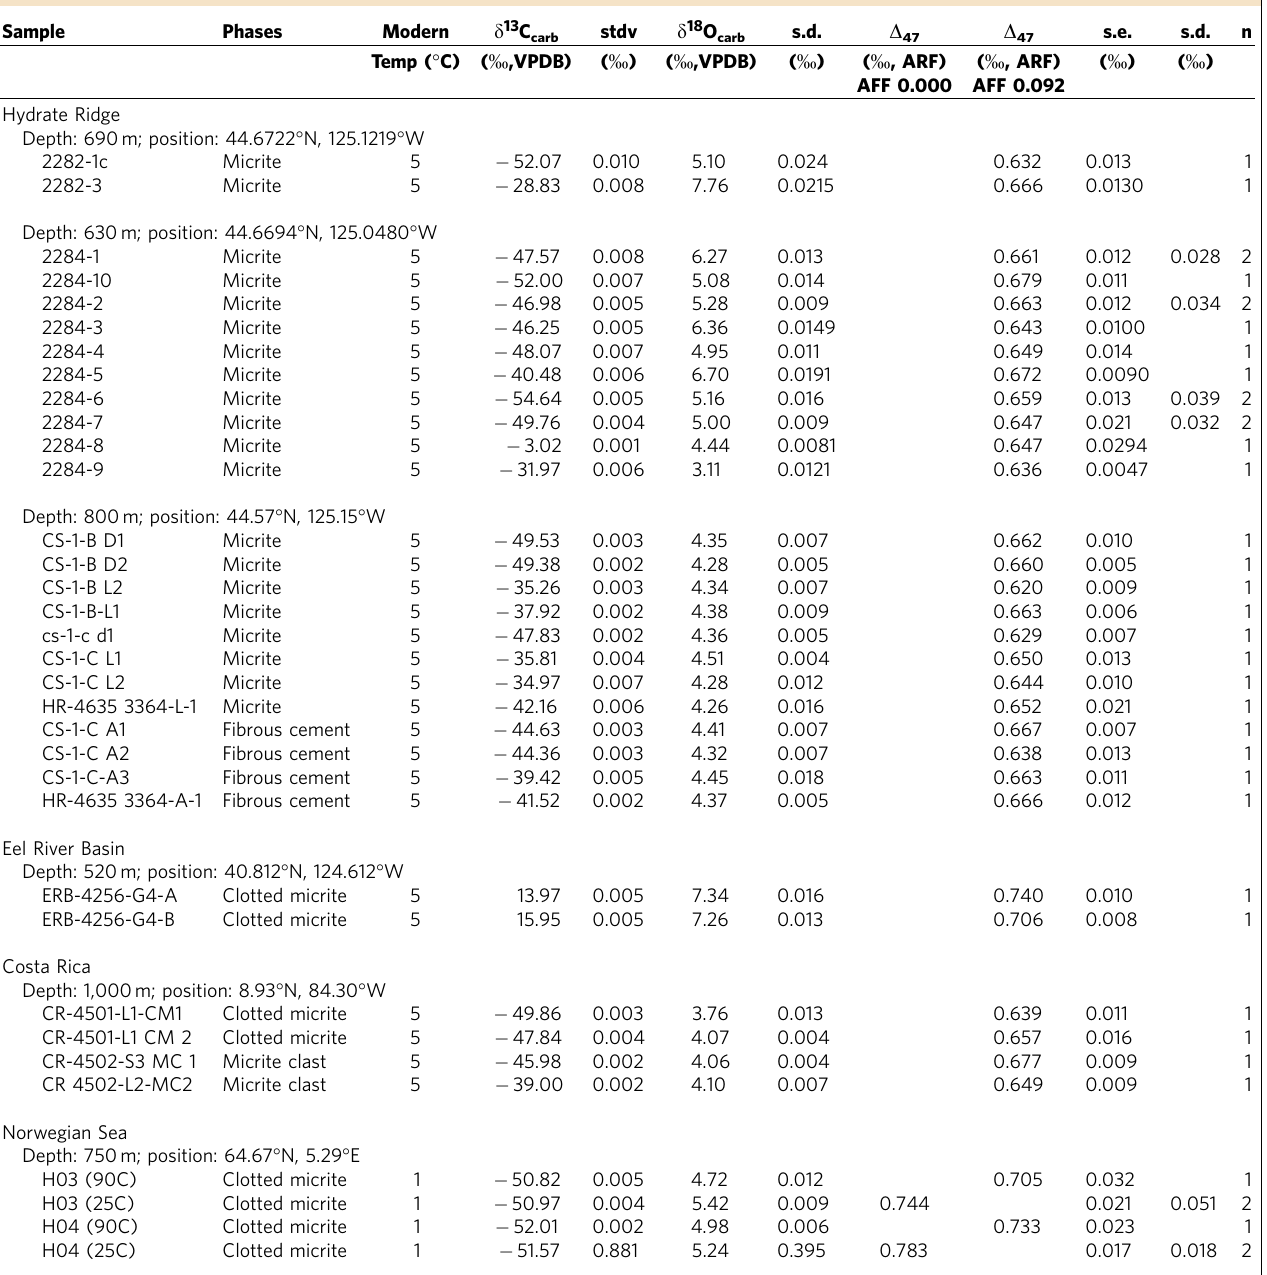
Table 1 | Modern seep carbonate geochemical data Sample Phases